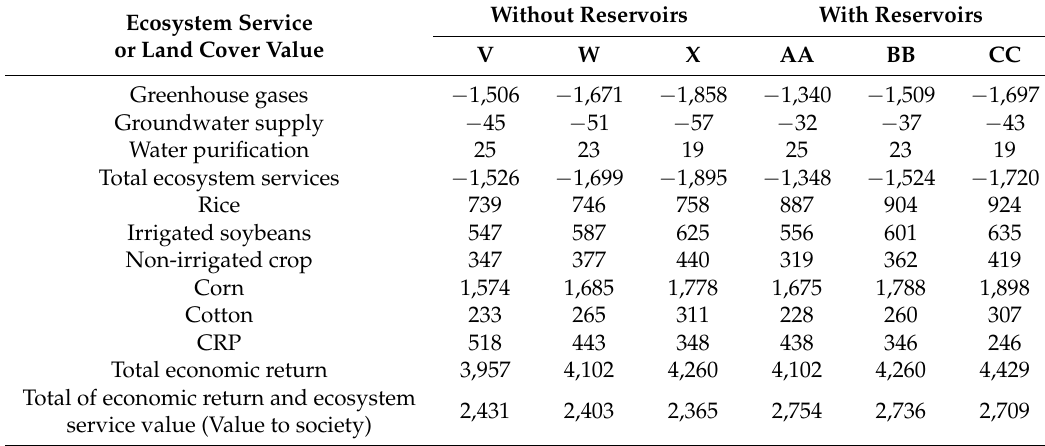
Table 4. Present value of economic returns and ecosystem services for select points on the efficiency frontier optimizing water purification value (in millions of 2013 constant dollars).